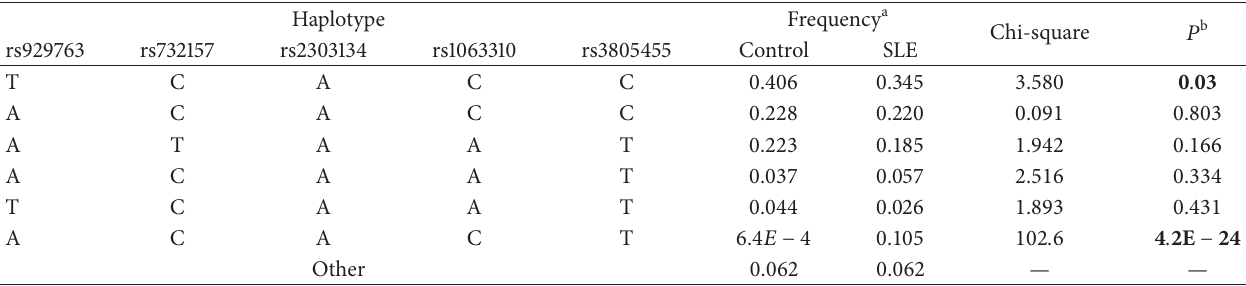
a Values were constructed by EM algorithm with genotyped SNPs. b Values were analyzed by permutation test or